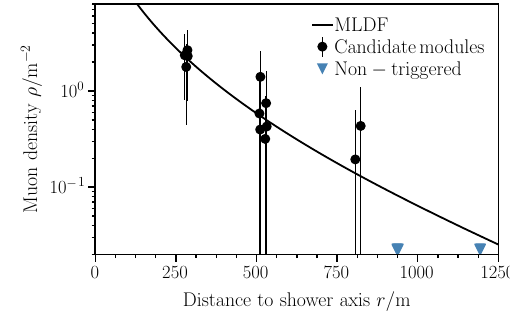
Fig. 8 Example of MLDF fit to a real